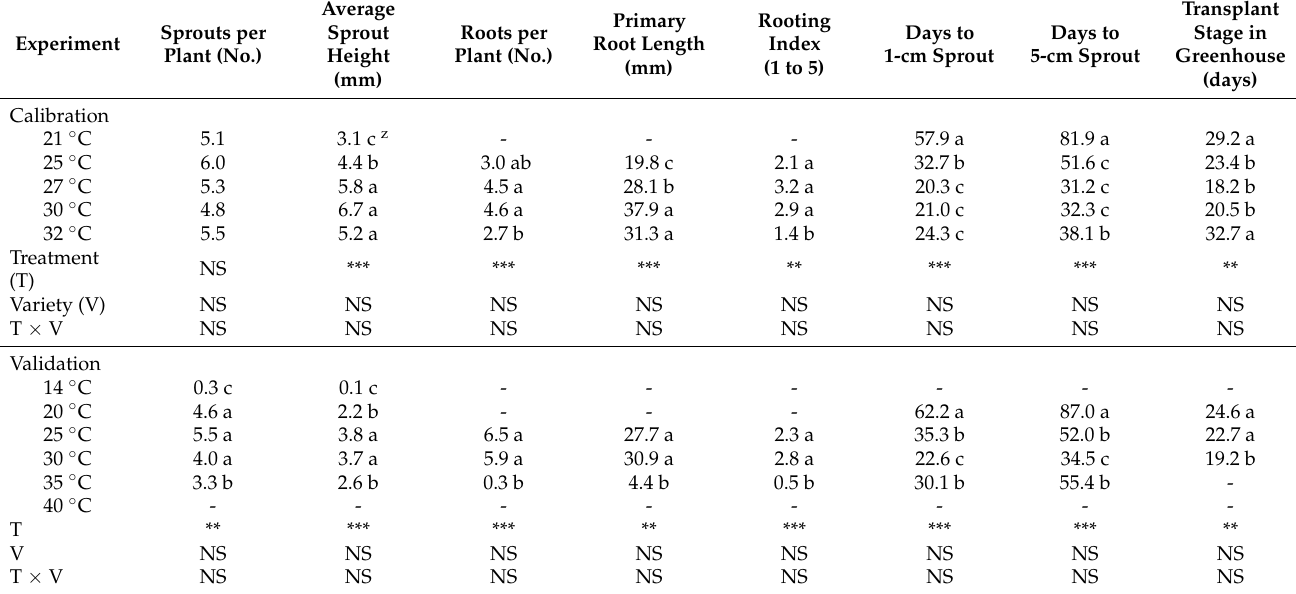
Average Transplant Primary Rooting Sprout Roots per Days to Days to Stage in Root Length Index Height Plant (No.) 1-cm Sprout 5-cm Sprout Greenhouse (mm) (mm) (days)